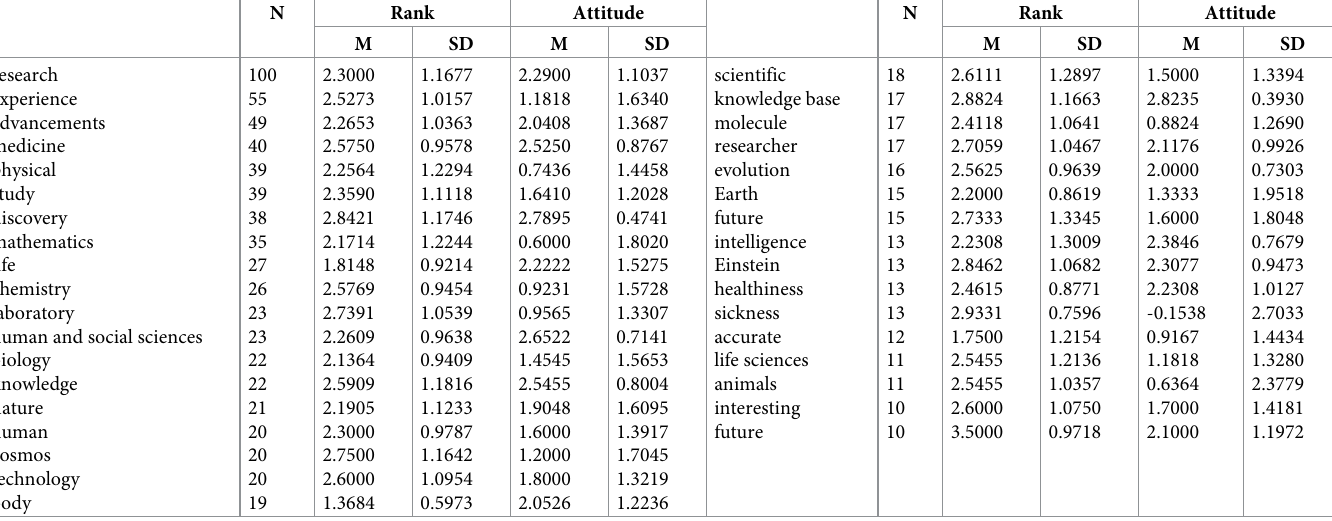
Table 9. Attitudes and average ranks associated with the terms most frequently associated with science by participants. N